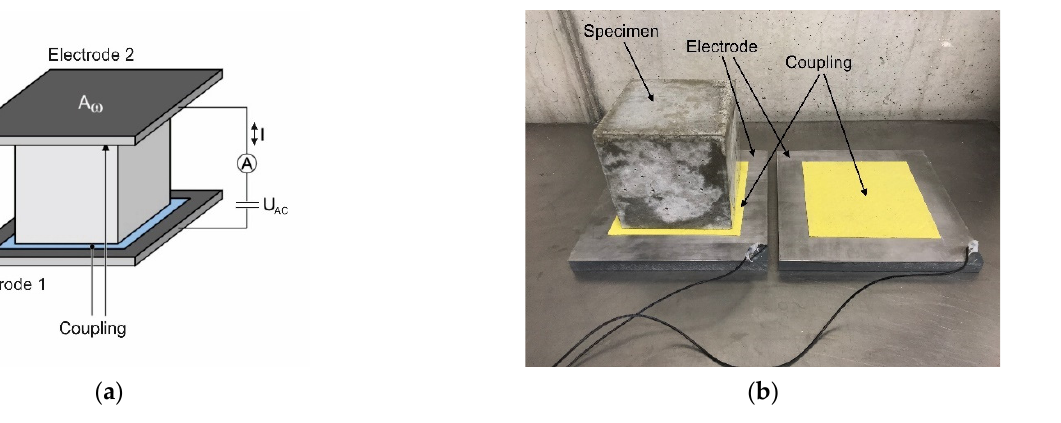
Figure 2. Test setup for conductivity measurements, schematical setup ( a ) and photo of a test setup with the investigated specimen ( b ) by [1].